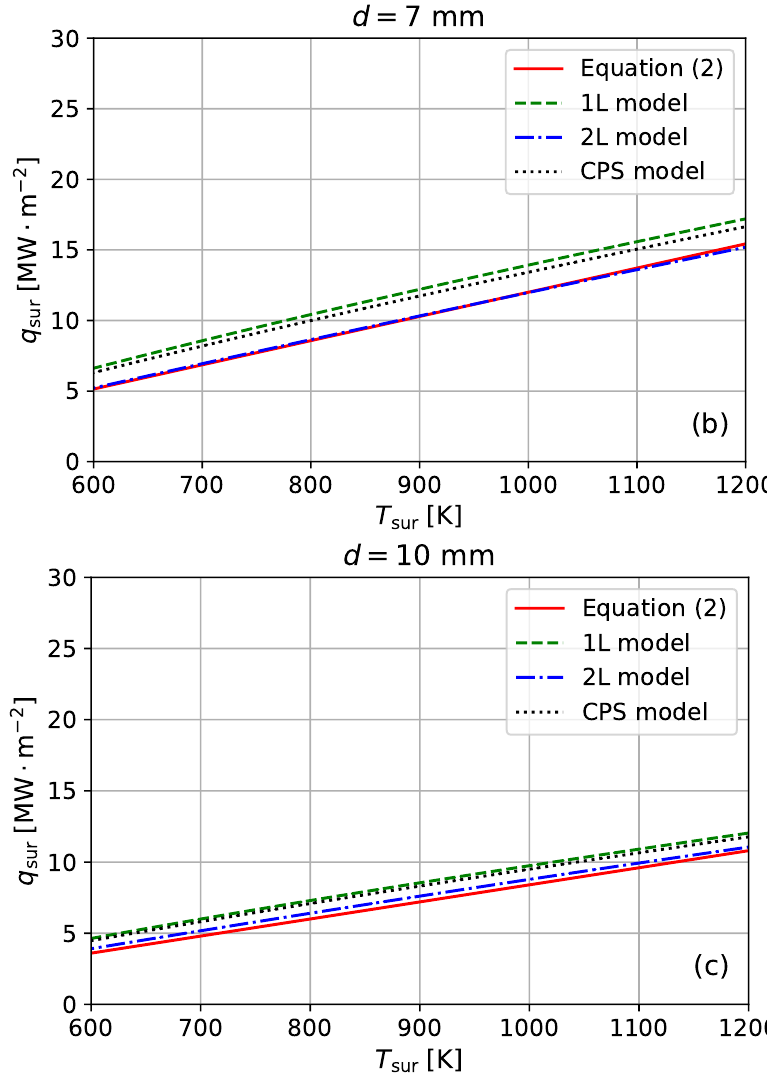
Figure 2. Heat flux q sur as a function of the surface temperature T sur for different target substrate models and three thickness values: 4, 7, and 10 mm ( a – c ). The red solid line corresponds to a calculation via Equation (2); the green dashed curve corresponds to one-layer model (1 L); the blue dash-dotted curve corresponds to a two-layer model (2 L); the black-dotted curve corresponds to the CPS